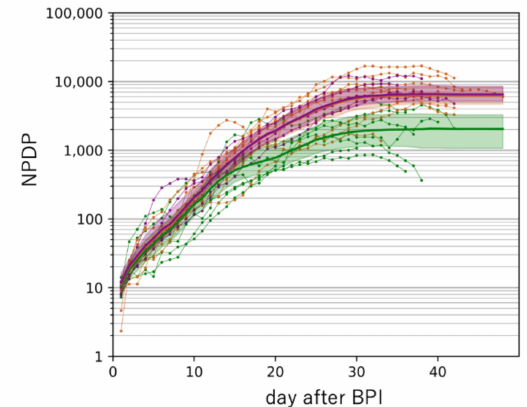
Figure 4. Estimation of the time course of NPDP after BPI in Western countries by machine learning analysis classified by the positive rate of the PCR test. Green, orange, and purple lines indicate positive rates of 0.0–6.9%, 7.0–16.9%, and 17.0–28.0%, respectively. Each colored area represents a 5–95% confidence interval of the median estimated by bootstrap analysis. The orange and purple lines and areas completely overlapped. NPDP: number of population-adjusted daily test-positive cases.